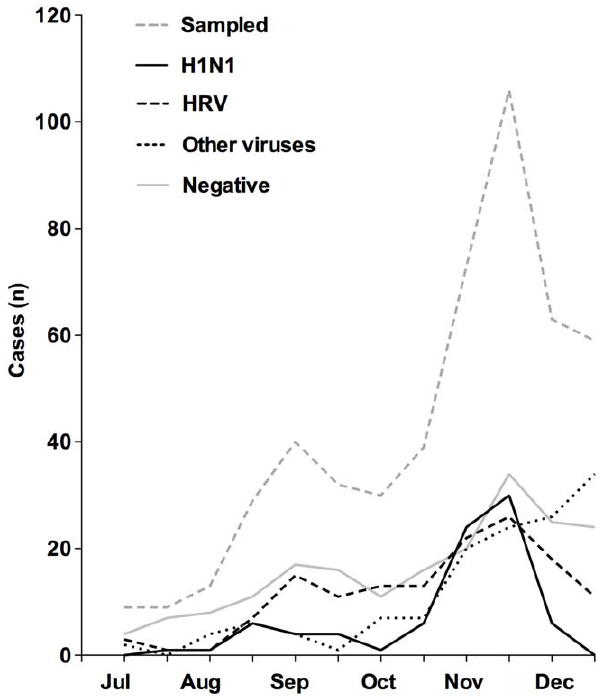
Figure 1. Prevalence over time. Total number of detected viruses among children with influenza-like illness at Astrid Lindgren Children’s Hospital, Karolinska University Hospital, Stockholm during the influenza A(H1N1)pdm09 pandemic. Included is also the number of PCR-negative children (neg, n=193) as well as total number of sampled children (n=502).